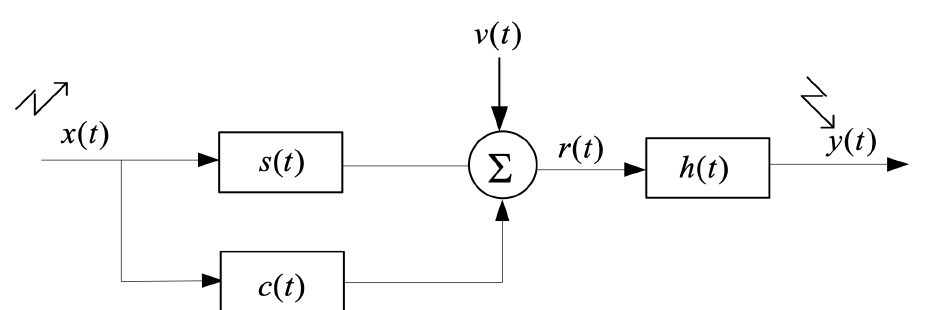
Figure 2. Model of the received signal. x ( t ) is the transmitted signal, s ( t ) is the extend target impulse response with the spectral variance σ 2 s ( f ) , c ( t ) represents the clutter with the spectral variance σ 2 c ( f ) , v ( t ) represents ambient noise with the spectral variance σ 2 v ( f ) , r ( t ) is the received baseband signal, h ( t ) is the receiver-filter, and y ( t ) is the receiver